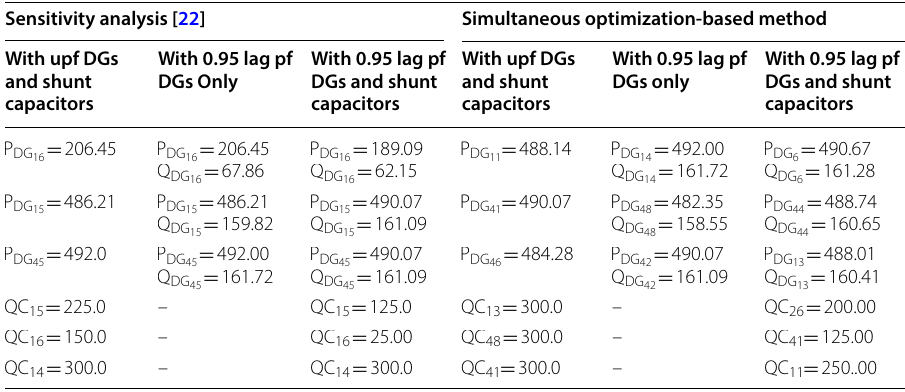
Table 4 Optimum sizing of DGs and shunt capacitors for 69-bus system Sensitivity analysis [22] Simultaneous optimization-based method With upf DGs With 0.95 lag pf With lag pf With upf DGs and shunt DGs only DGs and shunt and capacitors capacitors